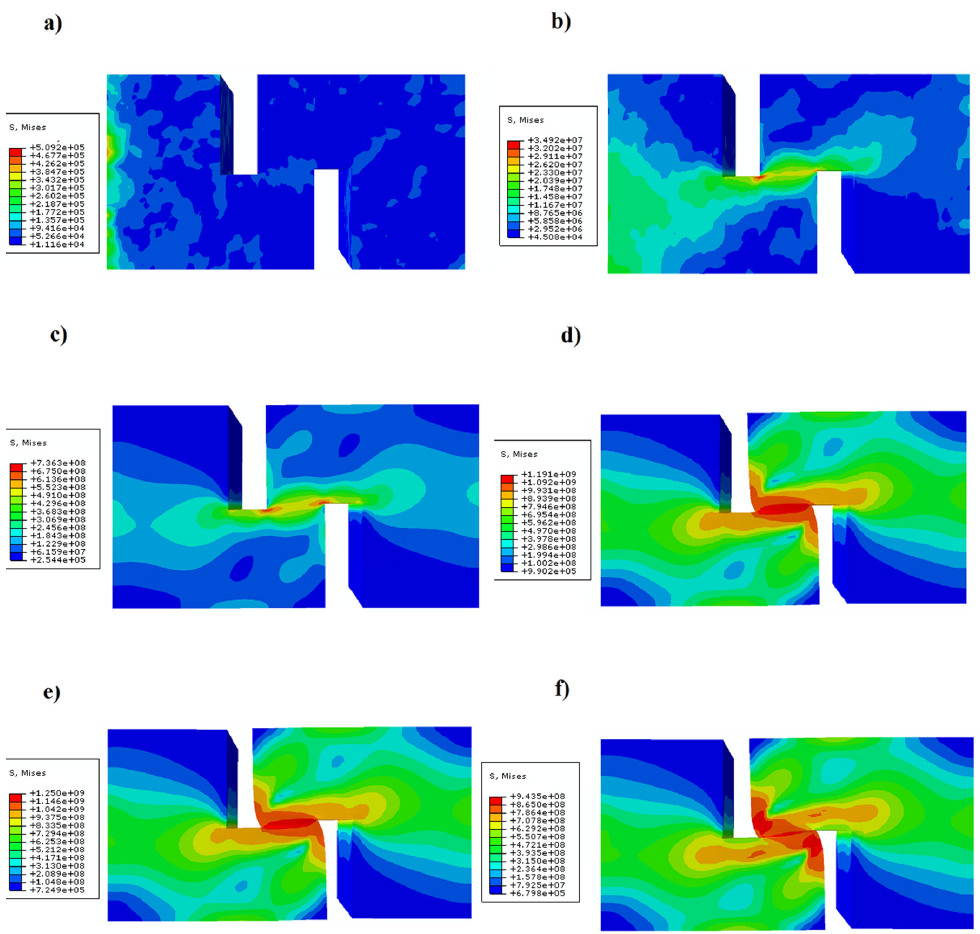
Figure 15. Contour of the equivalent stress on the NSSS surface ( a ) 0 µ s, ( b ) 6.6 µ s, ( c ) 30 µ s, ( d ) 60 µ s, ( e ) 90 µ s, and ( f ) 110 µ s.